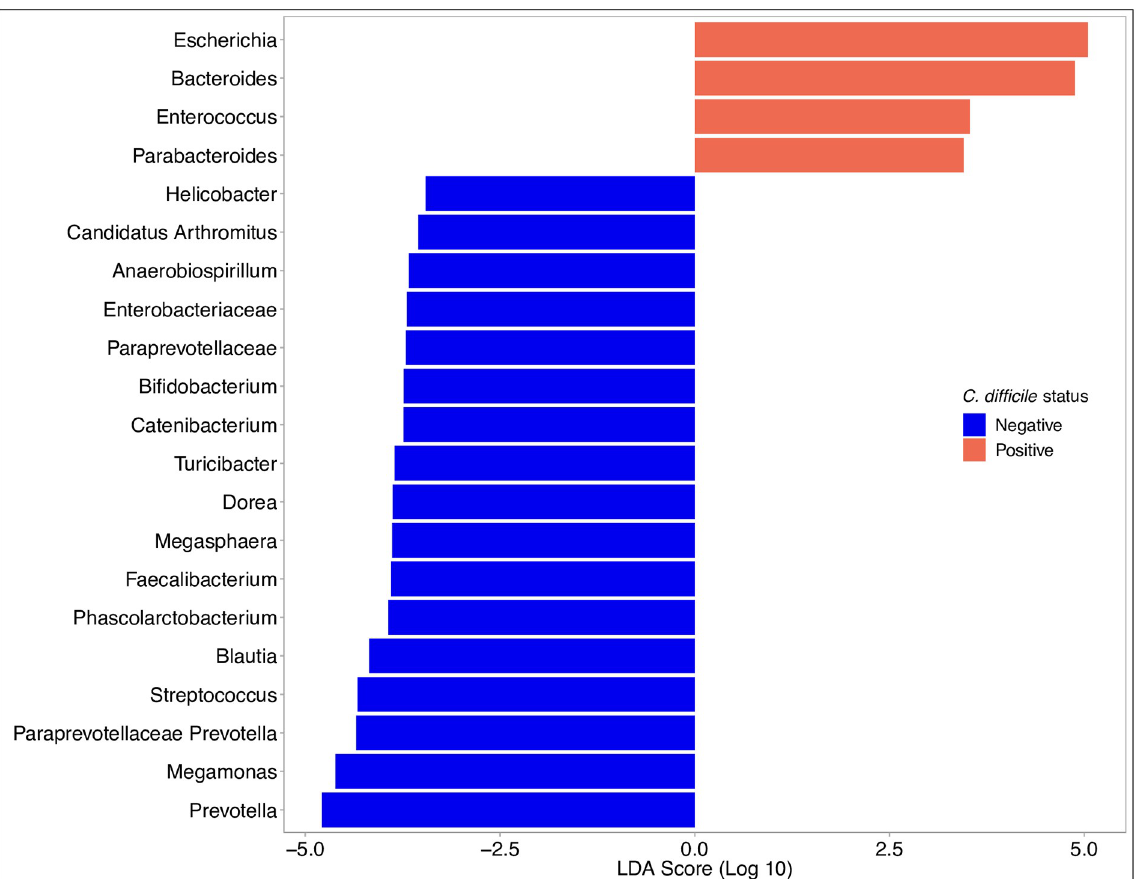
Fig 5. Linear discriminant analysis effect size analysis shows genera of bacteria that are differentially expressed in the C . difficile -positive and C . difficile -negative fecal samples from puppies in the greater Philadelphia area. Only organization taxonomic units with > 5% relative abundance in one or more samples and with LDA scores > 2.0 are